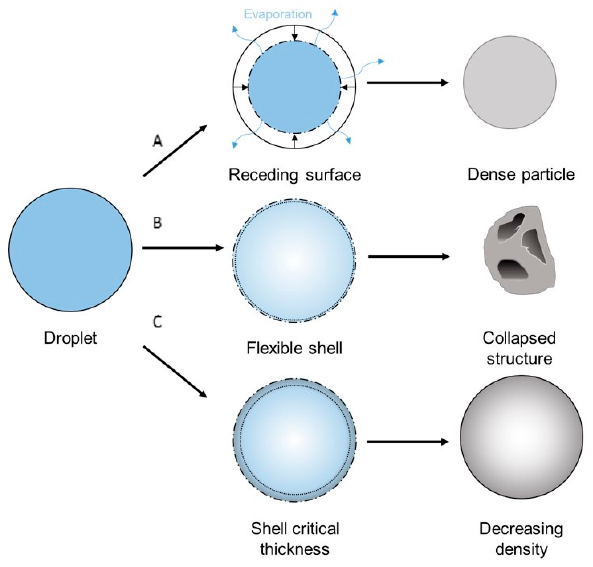
Figure 11. Evaporation model that illustrates possible morphology occurrence depending on parameters used. parameters used.